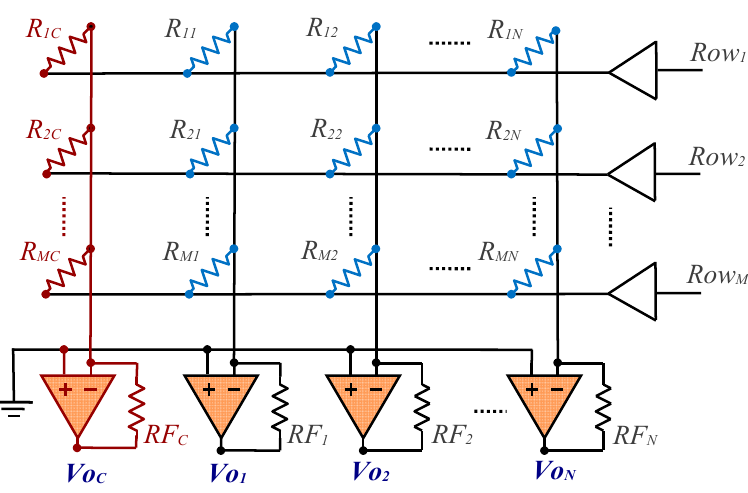
Figure 3. Circuit with the resistor array to be measured (in blue) along with the additional calibration column (in red) for Method I.